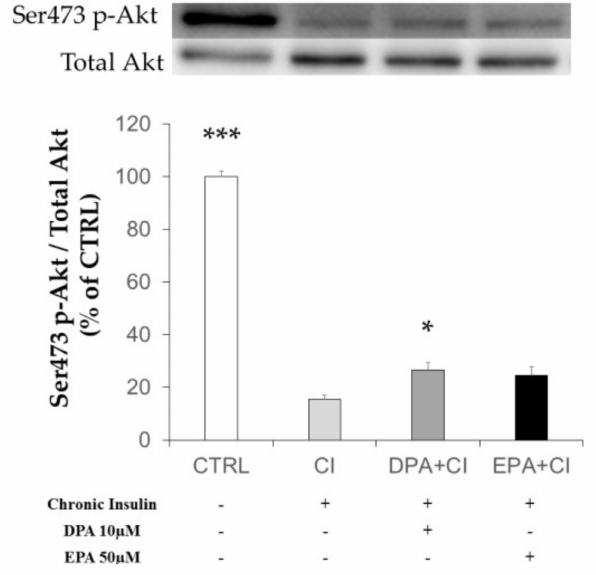
Figure 3. Effects of chronic insulin and LCn-3PUFA on insulin signaling in mature